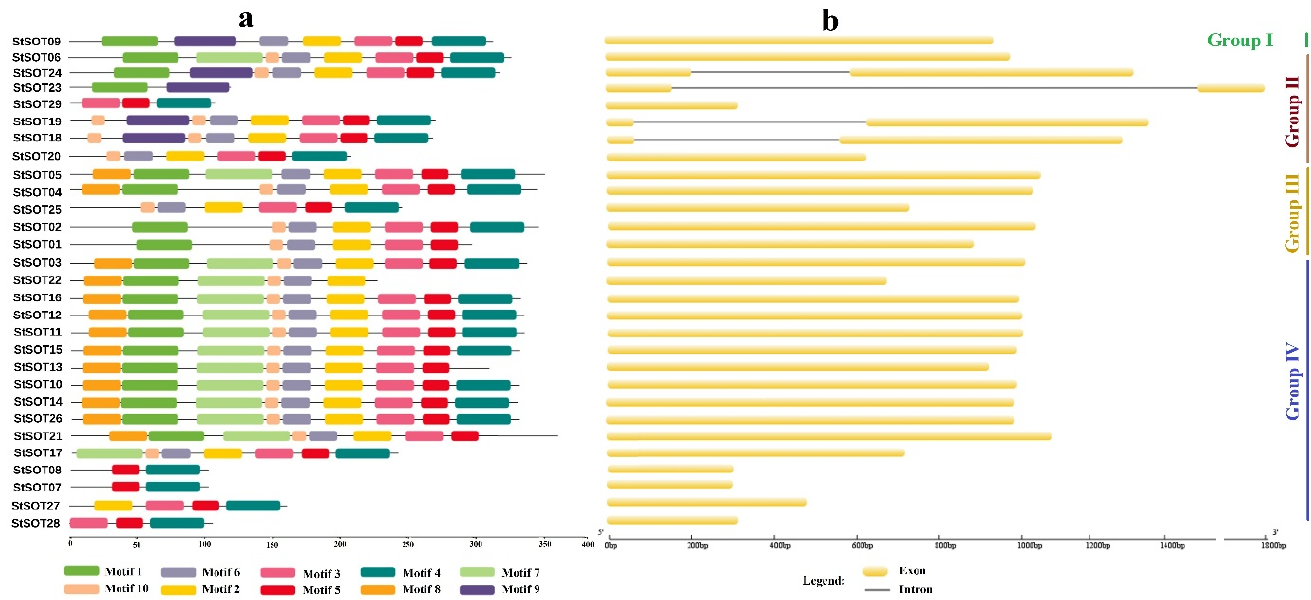
Figure 3. Conserved motifs predicted in the StSOT protein sequences ( a ). Exon–intron structure predicted in the StSOT family genes ( b ). Two important functional 5 ′ PSB and 3 ′ PB regions were detected in the motif 1 and motif 6, respectively.